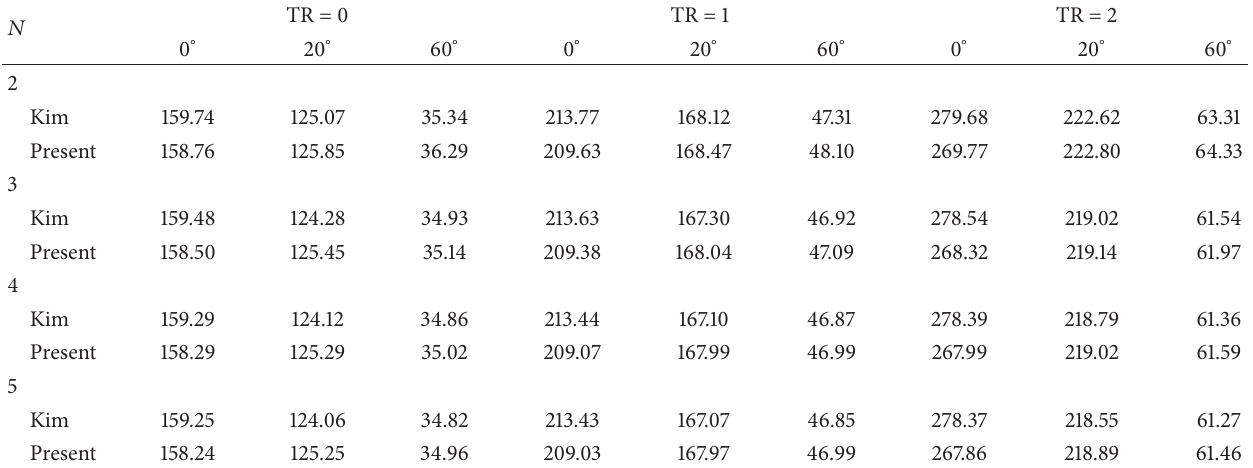
Table 4: Effect of mode number 𝑁 on the first natural frequencies ([ 𝜃 / −𝜃 ] 3 , Ω = 0 rad/s).